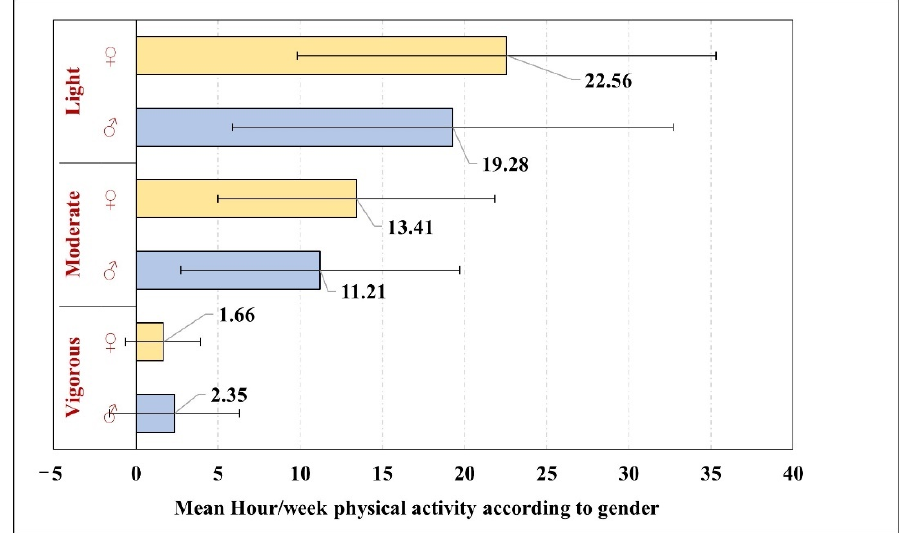
Figure 2. The means of light, moderate and vigorous activity hours for C-DS according to the child’s gender.